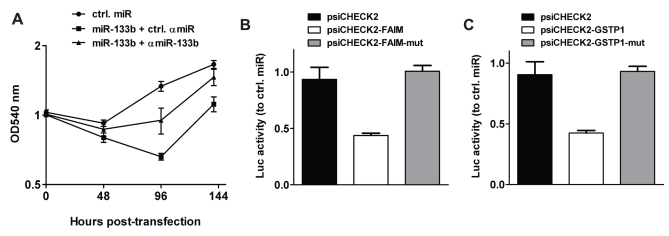
Prostate cancer cells treated with miR-133b show impaired vitality.(A) MTT proliferation assay. PC3 cells were transfected with ctrl miR (•) or, miR-133b together with ctrl αmiR (▪) or with a specific αmiR-133b (▴). Cellular viability and proliferation were determined 0, 48, 96 and 144 h post-transfection as described in Material and Methods. (B) 3′-UTR targeting reporter assay. PC3 cells were transfected with miR mimics and a luciferase reporter plasmid encompassing the complete 3′-UTR of FAIM (psiCHECK2-FAIM) or the 3′-UTR missing the miR-133b binding site (psiCHECK2-FAIM-mut). The empty psiCHECK2 vector was used as a negative control. Error bars indicate standard deviation. (C) Congruent to (B) except that luciferase assays were performed with a construct harboring the GSTP1 3′-UTR.